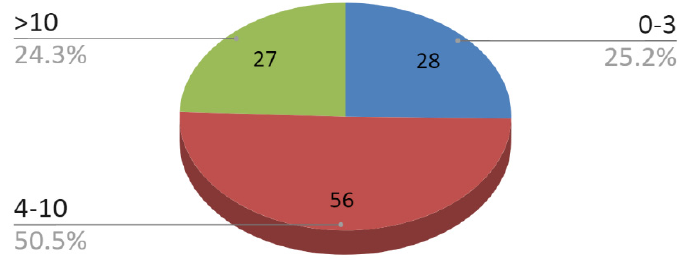
Figure 3. Time interval from trauma to surgery.